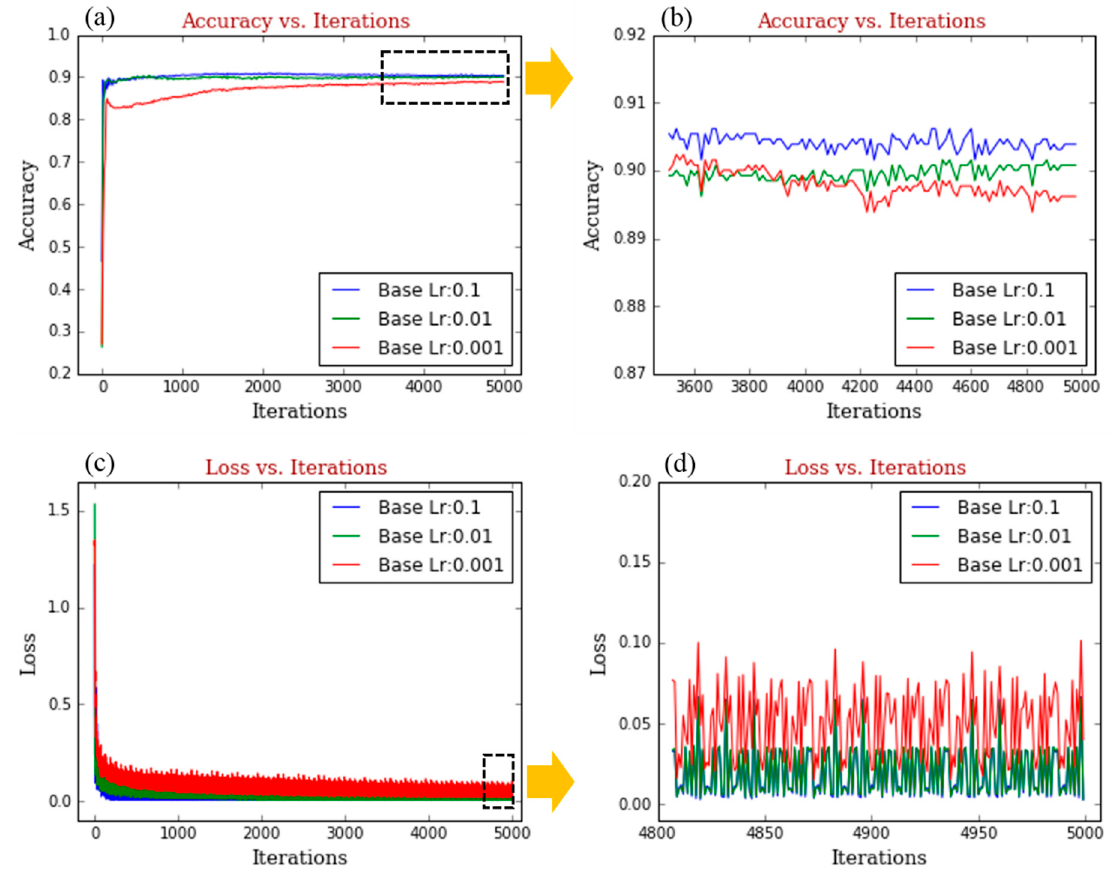
Figure 8. Accuracy and loss curves of different learning rates. ( a , b ) showed the change of accuracy; ( c , d ) displayed the change of loss.